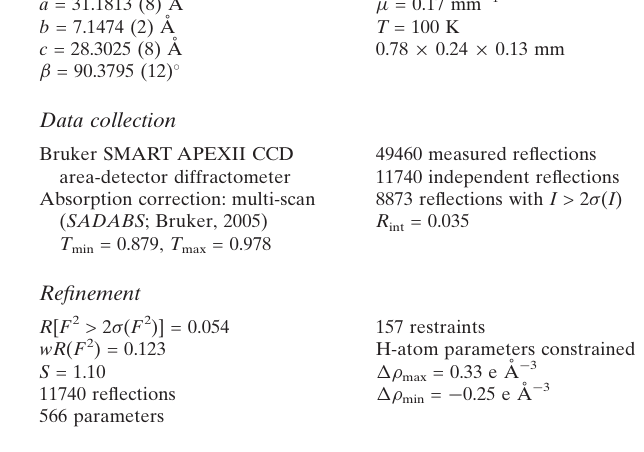
Bruker SMART APEXII CCD area-detector